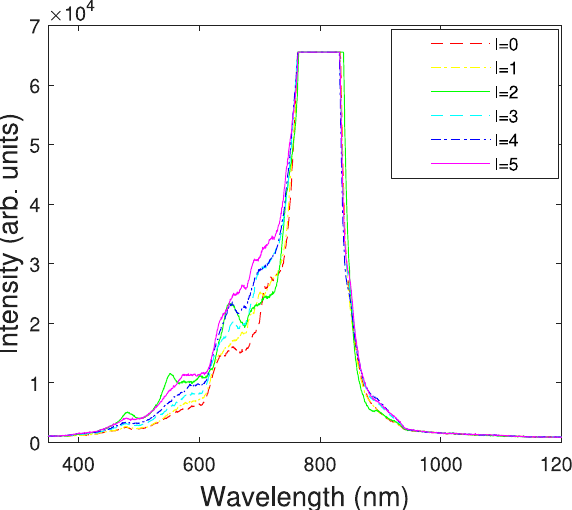
Figure 8. SC induced by the filamentation of BG beams with TC different values. The incident pulse energy is 188 μ J.